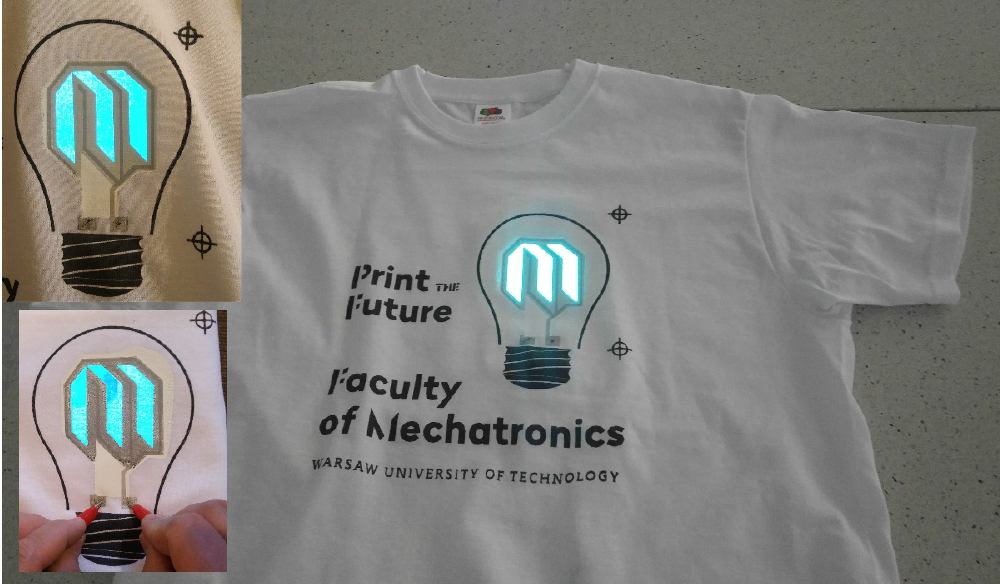
Figure 3. T-shirt with printed electroluminescent display. Upper left corner: Electroluminescent (EL) structure with carbon nanotube electrode, lower left corner: EL structure with an ATO-based electrode.